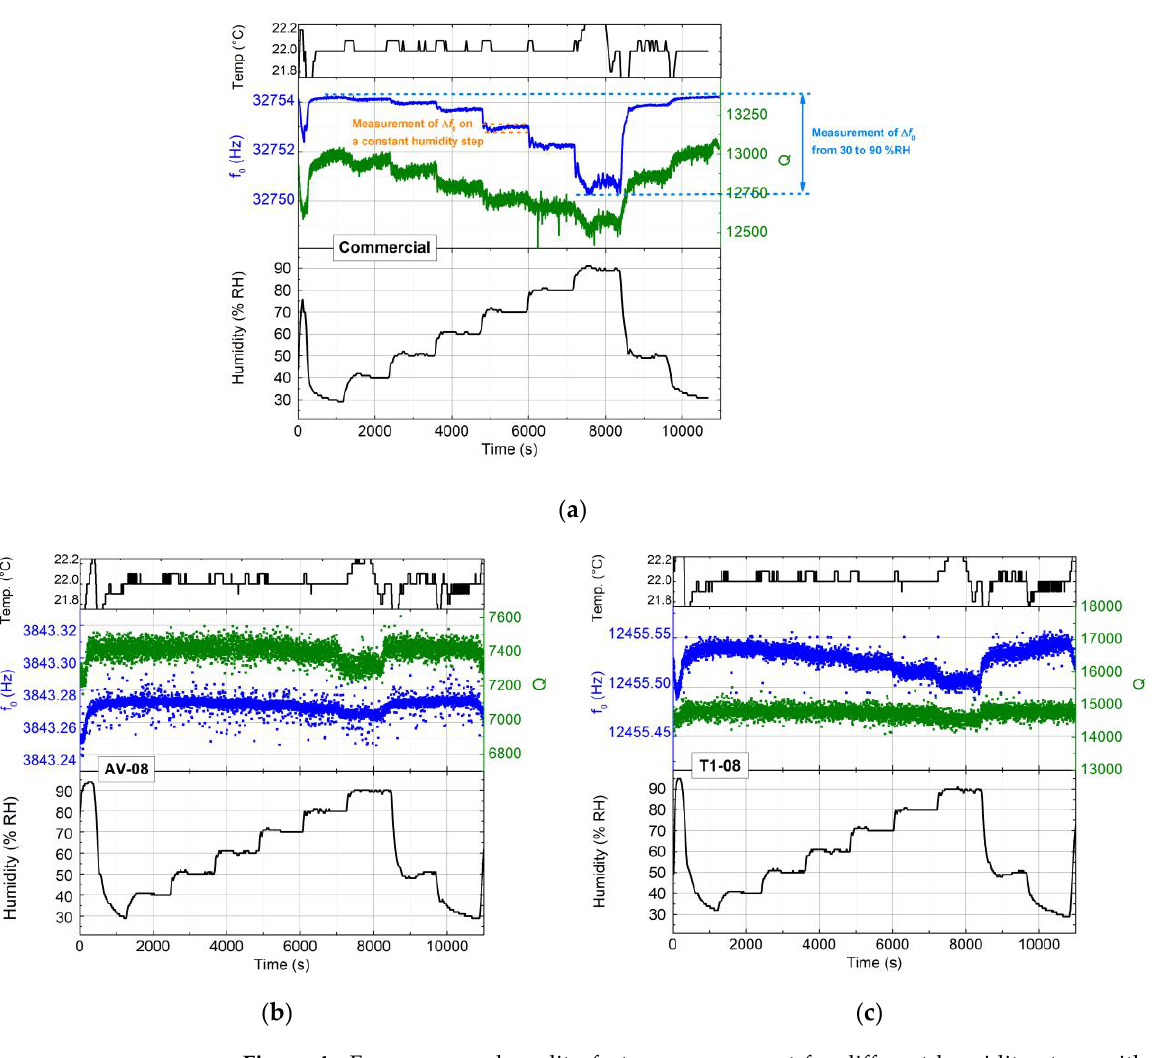
Figure 4. Frequency and quality factor measurement for different humidity steps with a fixed temperature of 22 °C. Humidity and temperature data were collected from the humidity chamber software. Variation of f 0 and Q were measured with a LabVIEW program. ( a ) commercial QTF, ( b ) AV-08 and ( c ) T1-08. The time constant of the LIA was set to 1 ms for proper BF demodulation. The study of f 0 and Q variation for different steps of humidity was performed in two conditions described in blue and orange dashed lines (Figure 4a).